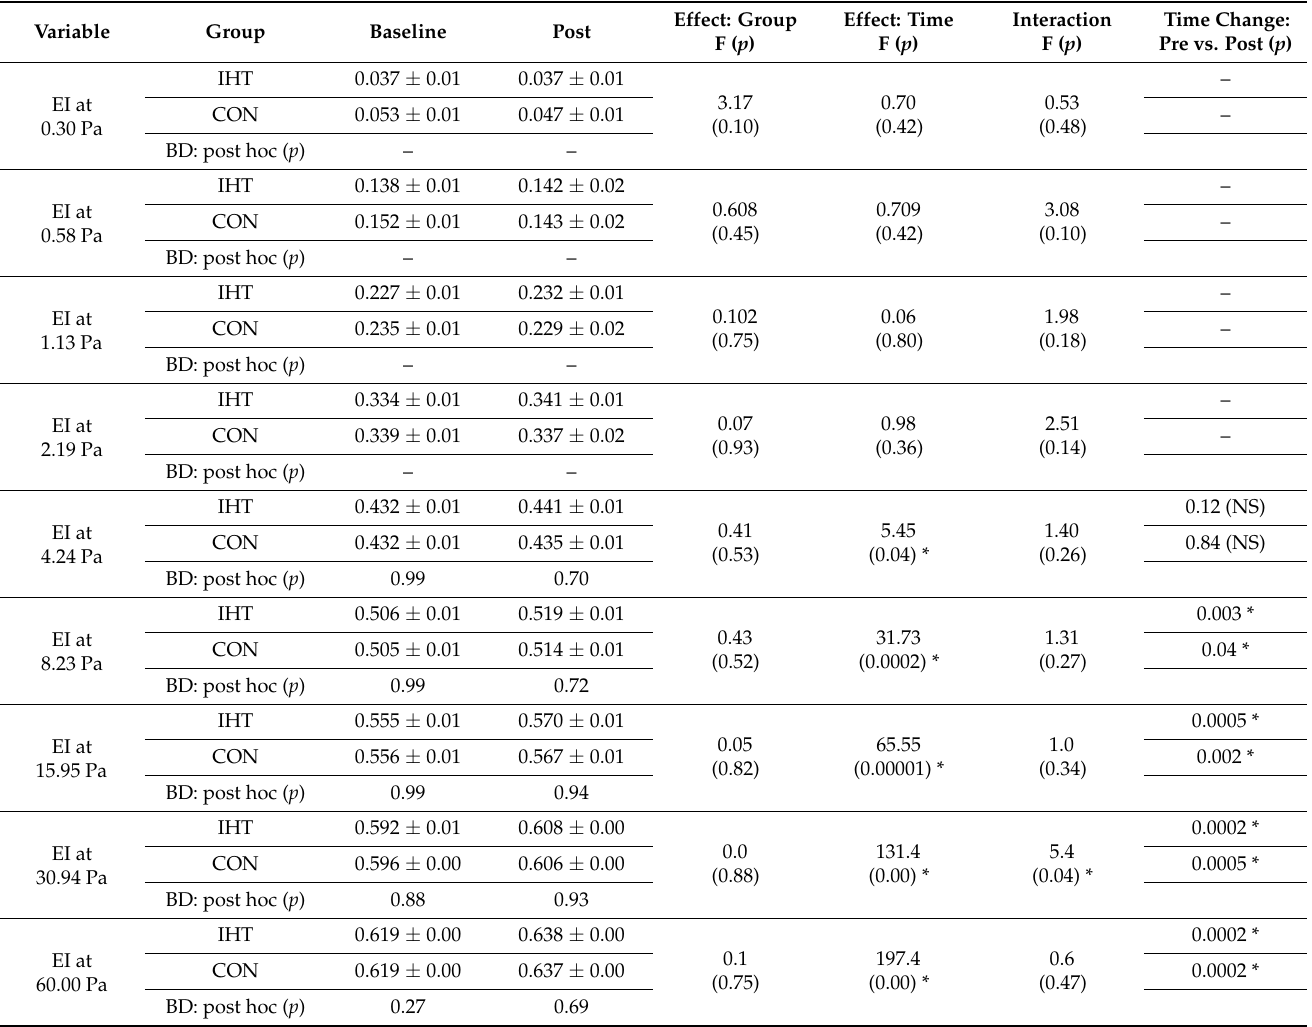
Table 4. Mean values ( ± SD) of the elongation index in rowers training in the hypoxia and normoxia (control) conditions before and after the